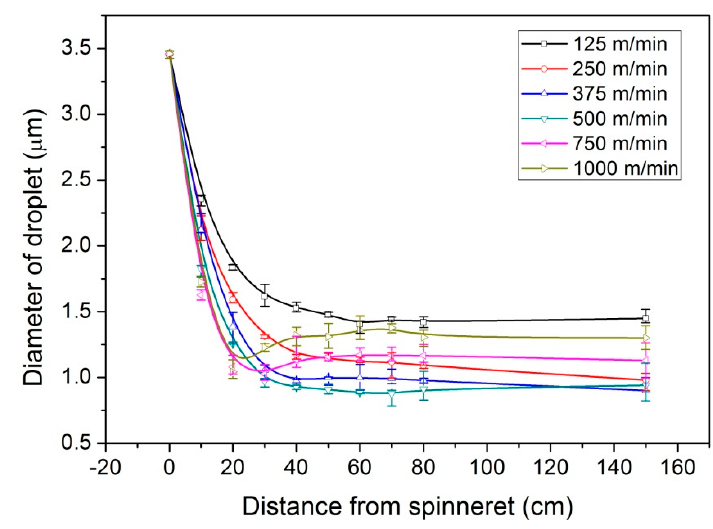
Figure 6. Number-average diameter of droplet versus distance from spinneret. Error bars show the maximum and minimum of the number-average diameter, and open symbols show the average diameter of the analyzed SEM micrographs of samples captured at each spinning line position. Symbols are connected with B-Spline solid lines [31]. Reproduced with permission from He, H.; Chen, L.; Zhang, Y.; Hong, S.; Zhou, Y.; Zhu, M., Fibers and Polymers; published by Springer Nature,